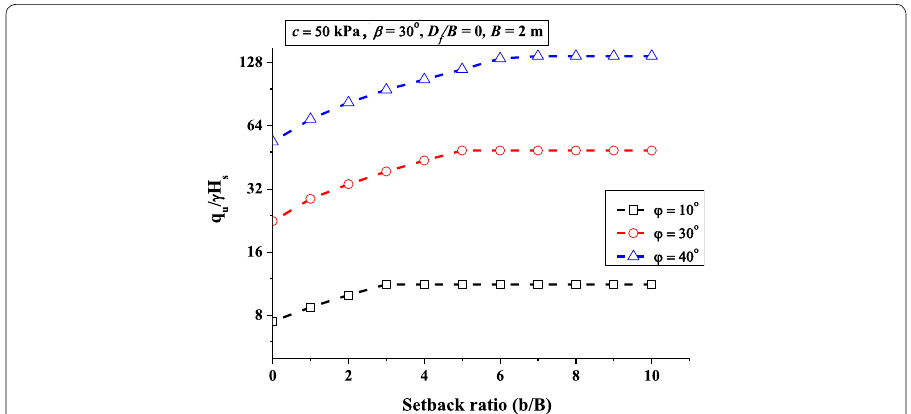
Fig. 12 Typical variation of q u / γH s with angle of internal friction ( φ ) and setback ratio ( b/B )